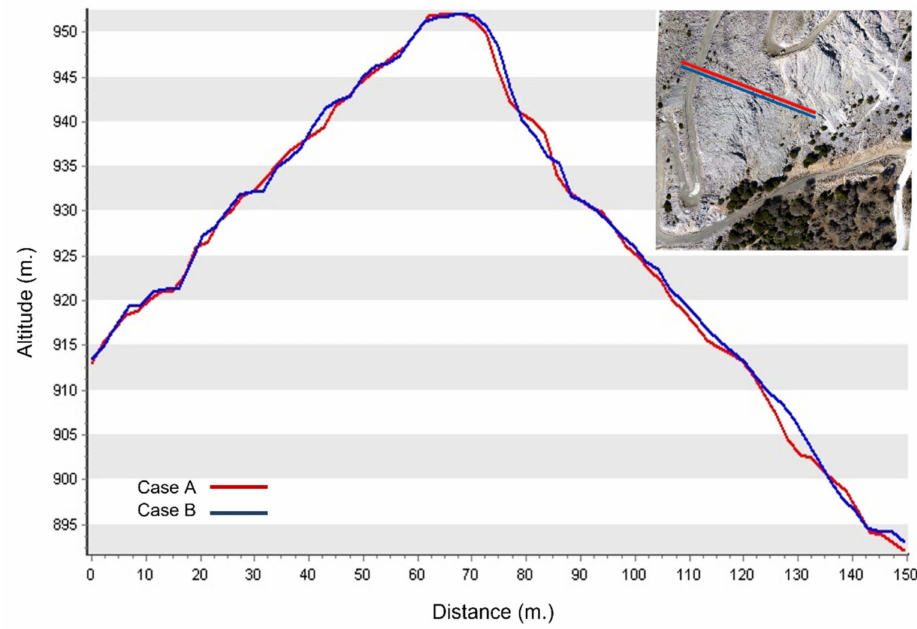
Figure 12. Dense point cloud profiles of the 150 m